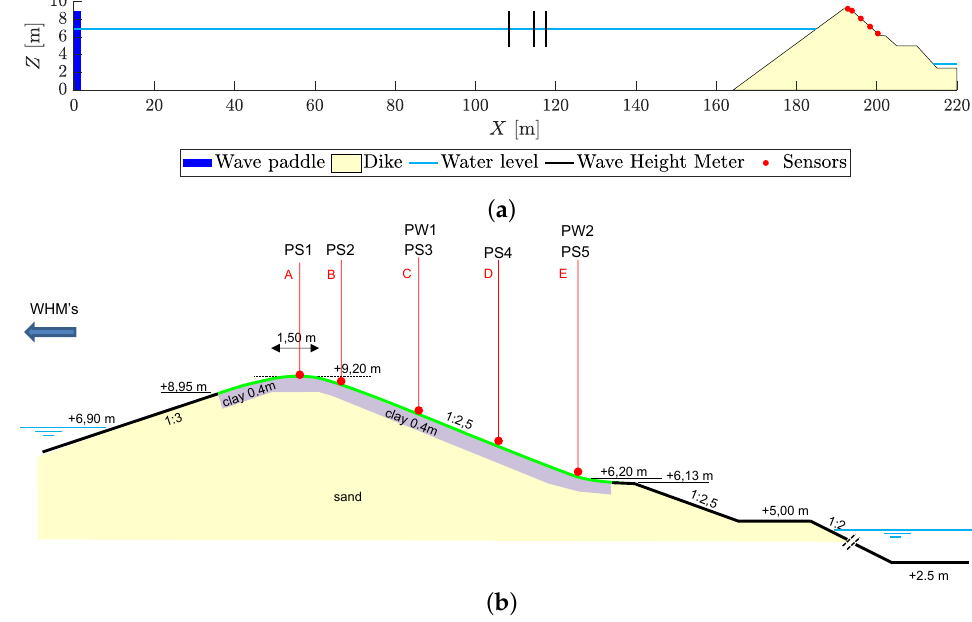
Figure 3. ( a ) Overview of test setup with wave paddle located at X = 0m, water level h = 6.9m and wave height meters located at X = 108.5,114.5 and 117.5m. ( b ) Cross section of the test set-up in the Deltares Delta Flume, including Wave Height Meter (WHM), Pressure Sensor (PS), and Paddle Wheel (PW), adapted from Van Steeg